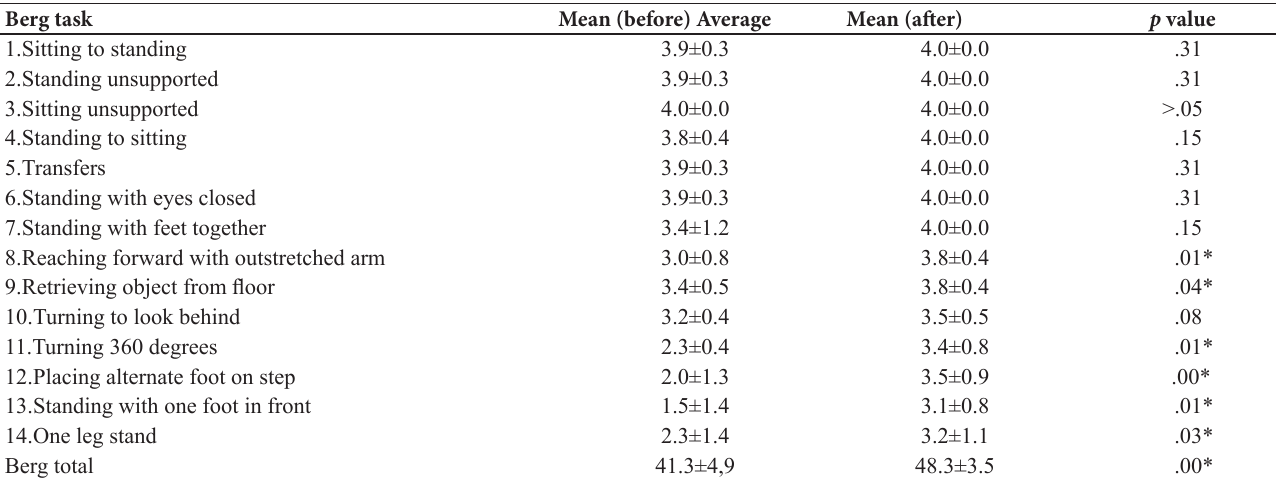
Table 2. BERG Balance Scale – Mean values before and after intervention. Berg task Mean (before) Average Mean